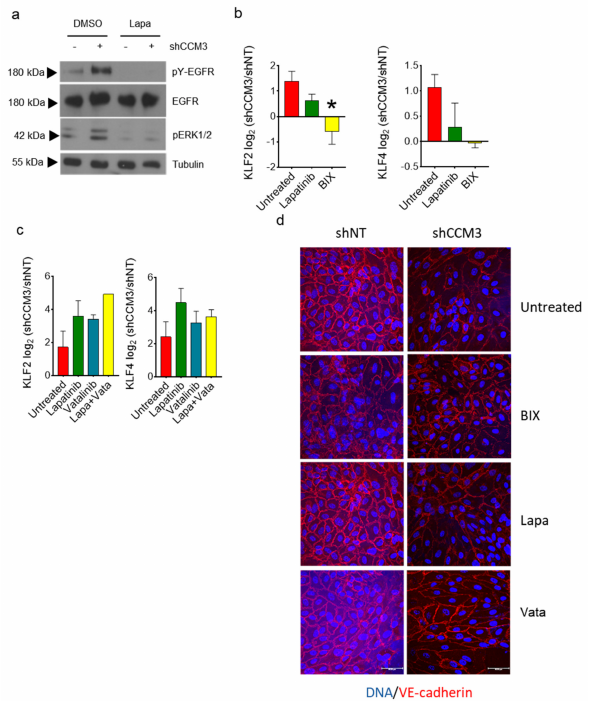
Figure 6. Inhibition of EGFR family receptors in CCM3-deficient cells does not a ff ect overexpression of KLF transcription factors or VE cadherin distribution; ( a ) A549 cells transduced with shNT and shCCM3 shRNAs were treated or not with the EGFR family inhibitor Lapatinib 10 µ M, and Western blots performed for the indicated proteins; ( b ) Di ff erence of KLF2 (left) and KLF4 (right) expression in A549 cells transduced with shNT or with shCCM3 shRNAs, treated or not with Lapatinib or the MEK5 / Erk5 inhibitor BIX02189. * p < 0.05; ( c ) Di ff erence of KLF2 (left) and KLF4 (right) expression in hCMEC / D3 cells transduced with shNT or with shCCM3 shRNAs, treated or not with Lapatinib or the VEGFR2 inhibitor Vatalanib; ( d ) VE cadherin (red) distribution in hCMEC / D3 cells transduced with shNT or with shCCM3 shRNAs, treated or not with Lapatinib, BIX02189, or Vatalanib. Images are shown merged with DAPI